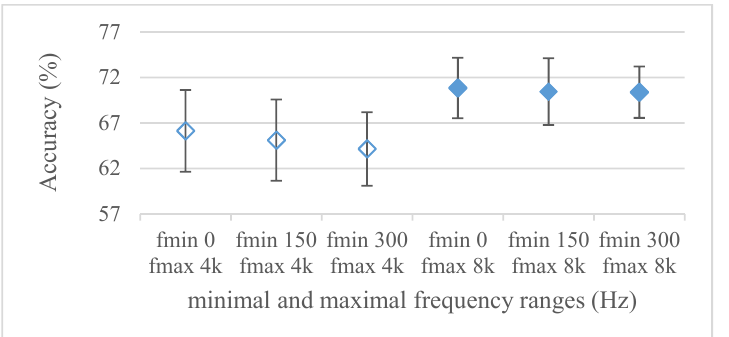
Figure 10. Averaged accuracies and standard deviations in case of Mel scale for minimal and maximal frequency limits; Fmin {0+, 150, 300 Hz}, Fmax {4, 8 kHz}, and with pre-emphasis. Filled marks show equally performing settings.